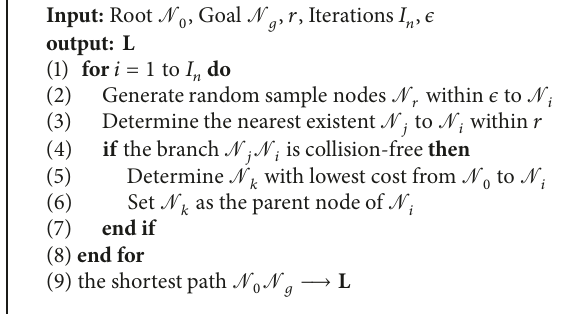
Algorithm 2: The RRT ∗ path planning